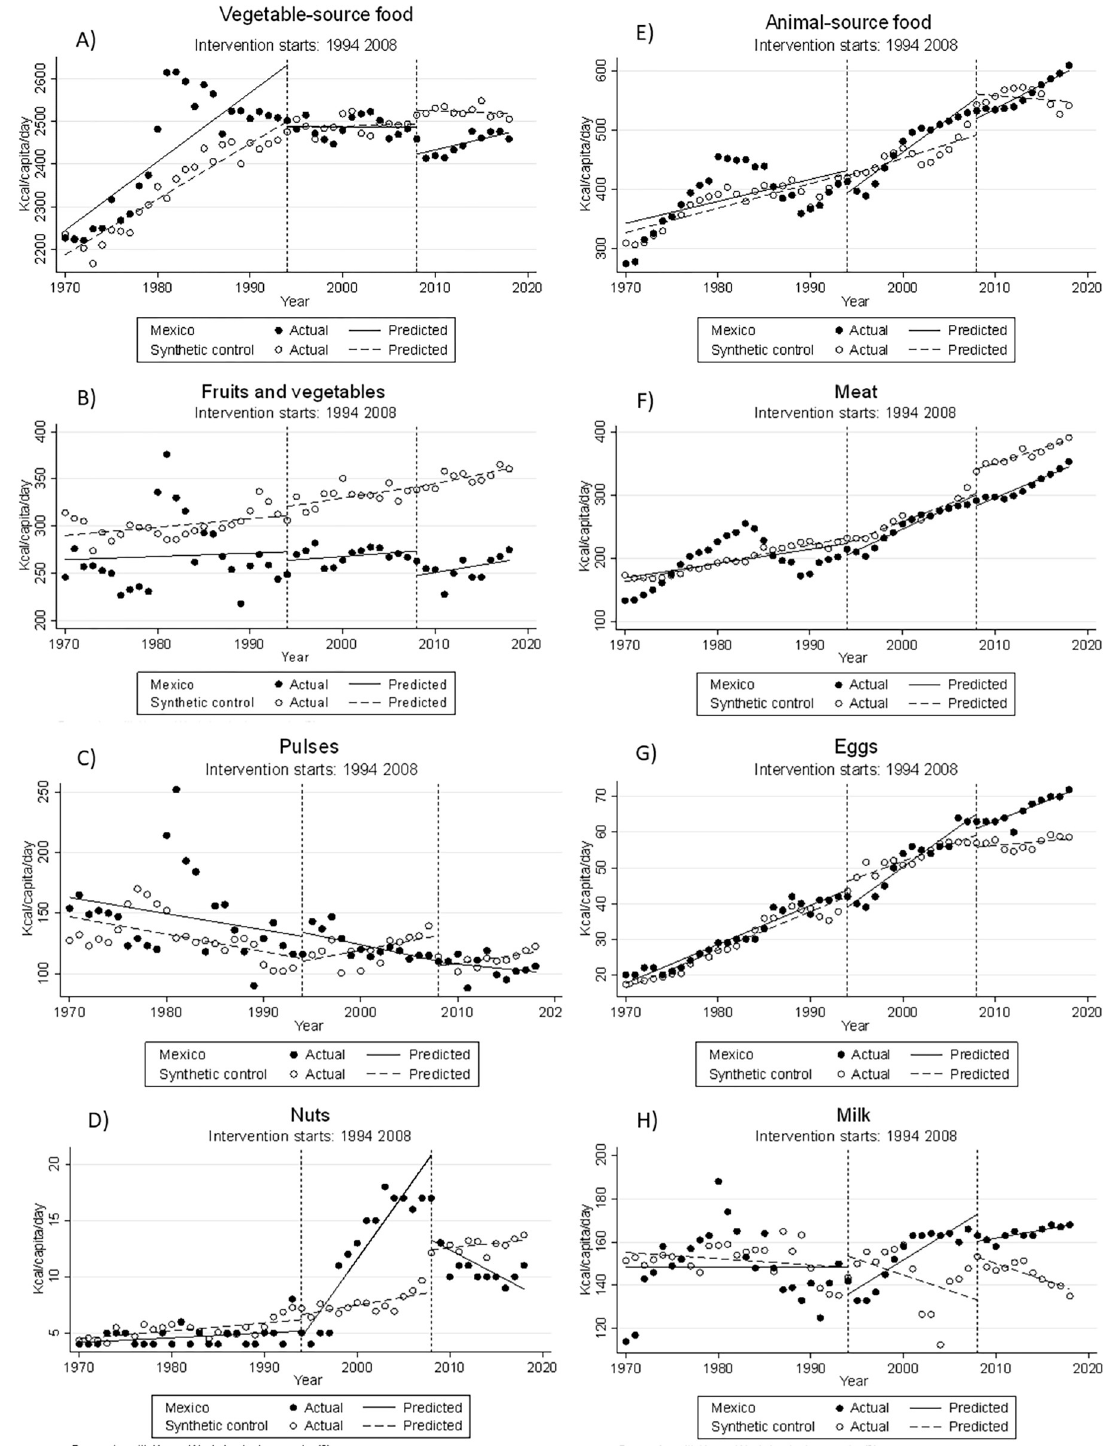
Fig 1. Observed and predicted values from the ITSA regression model before and after NAFTA implementation, comparing Mexico and the synthetic control (kcal/capita/day by food group). A) Vegetable-source food; B) Fruits and vegetables; C) Pulses D) Nuts; E) Animal-source food; F) Meat; G) Eggs; H) Milk. The control group was estimated by synthetic controls from a pool of lower- middle and upper-middle-income countries, adjusted for supply of fat and protein (gr/capita/day) provided by the modeled food group, gross domestic product, life expectancy at birth, Co2 emissions per capita, the proportion of the rural population, and primary school enrollment. https://doi.org/10.1371/journal.pgph.0001144.g001 PLOS Global PublicHealth | https://doi.org/10.1371/journal.pgph.0001144 November 23,